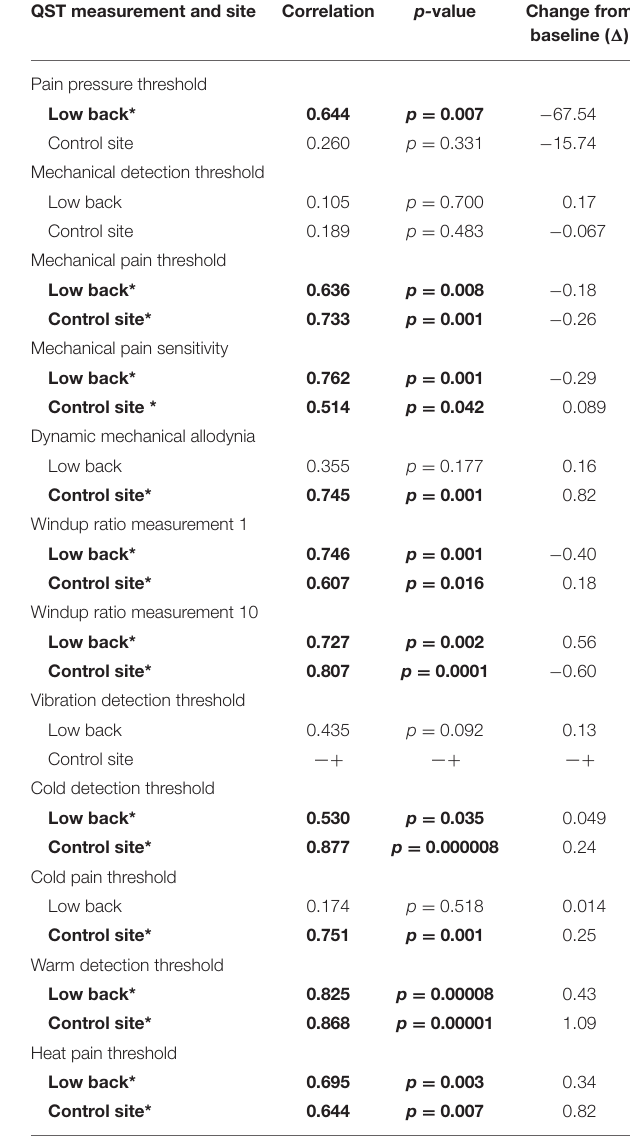
TABLE 4 | Correlation of quantitative sensory testing (QST) measurements at the site of pain and the control site in cLBP participants at the time of pain onset and a 6-month follow up